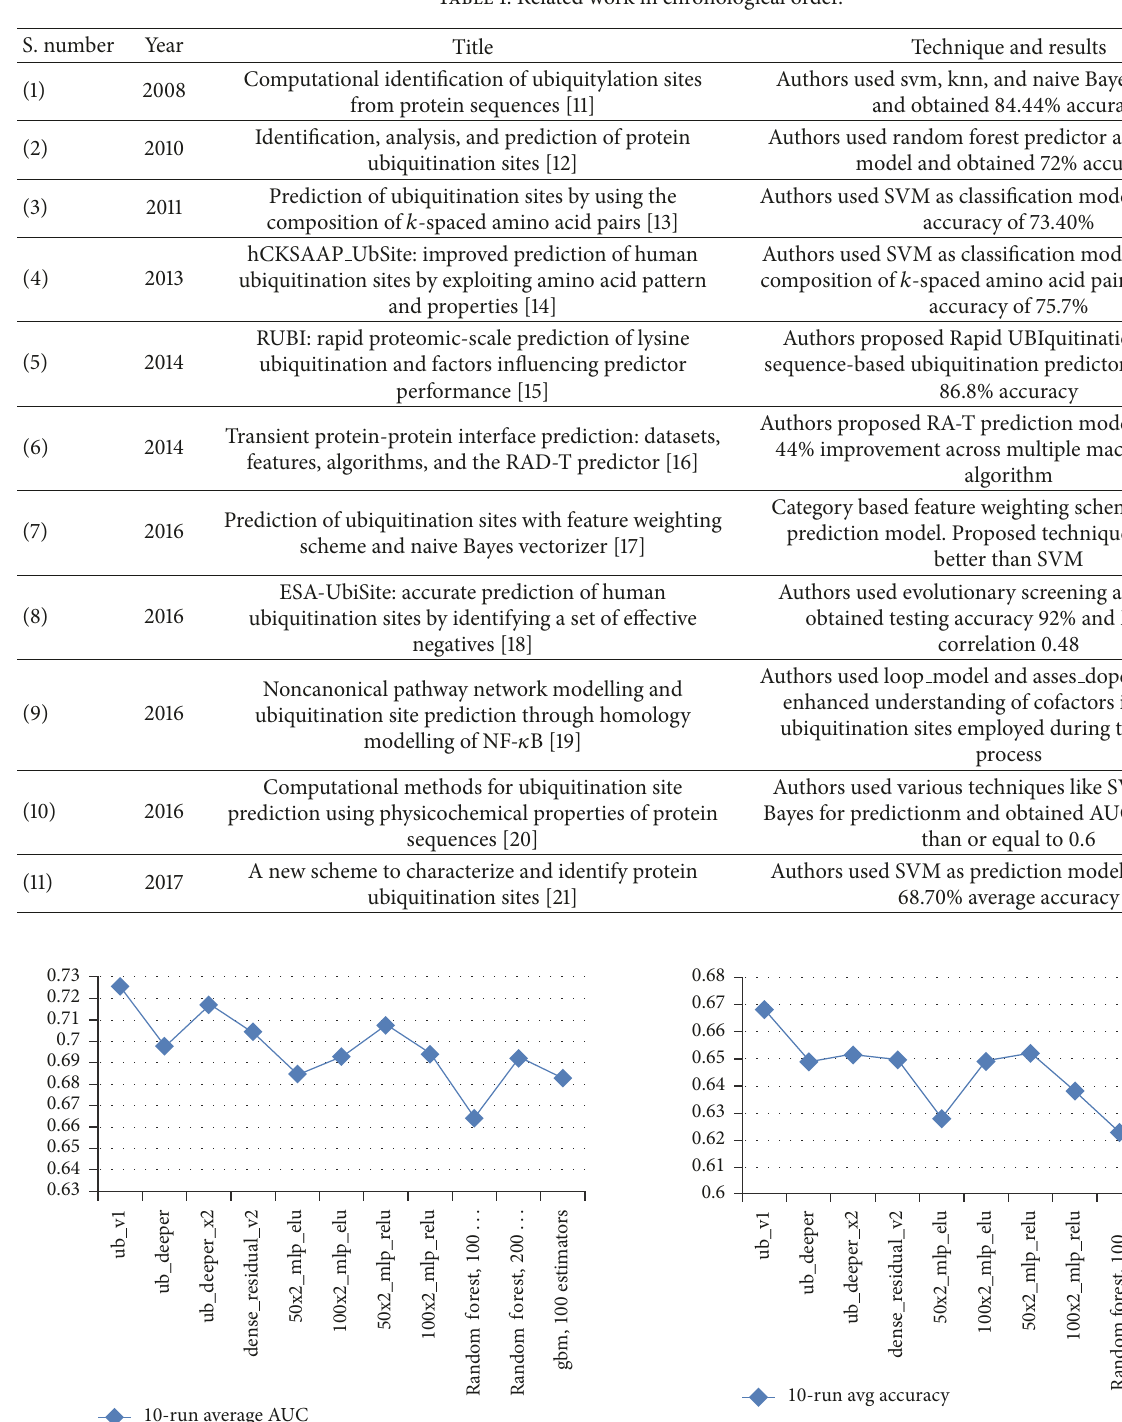
dataset 2, and dataset 3, respectively. Dense residual v2 generated best accuracy for dataset 1, dataset 2, and dataset 3.